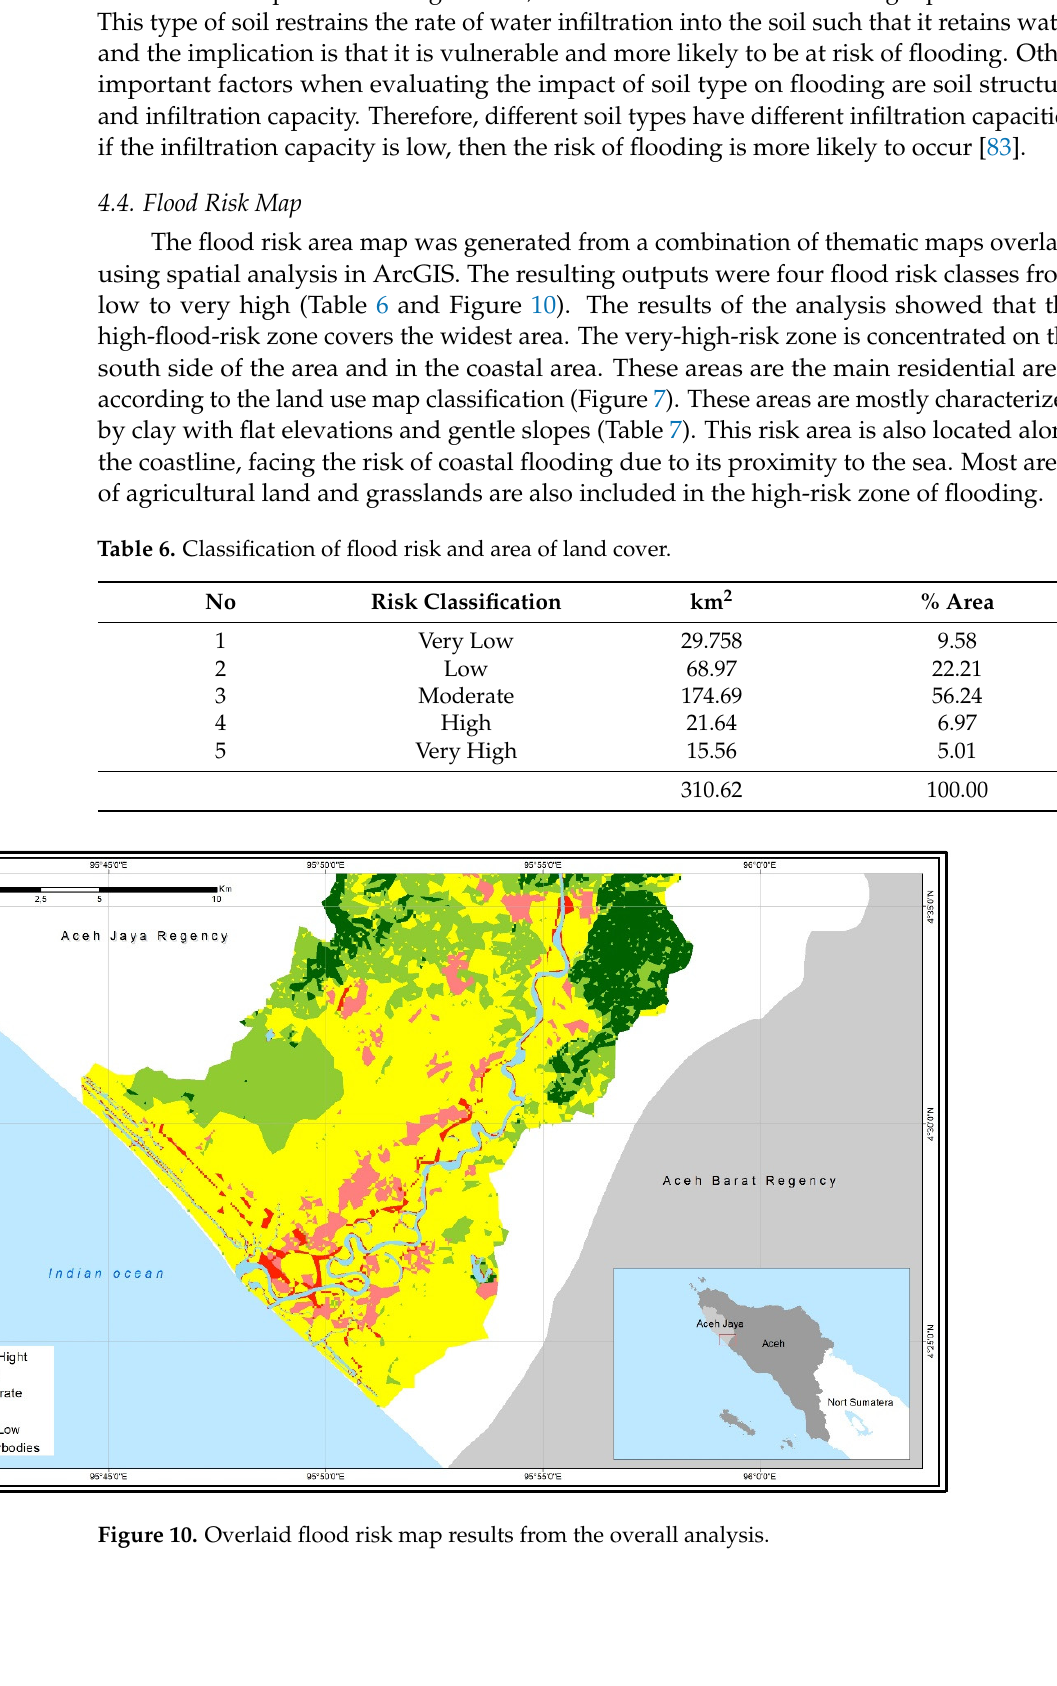
Table 6. Classification of flood risk and area of land cover.